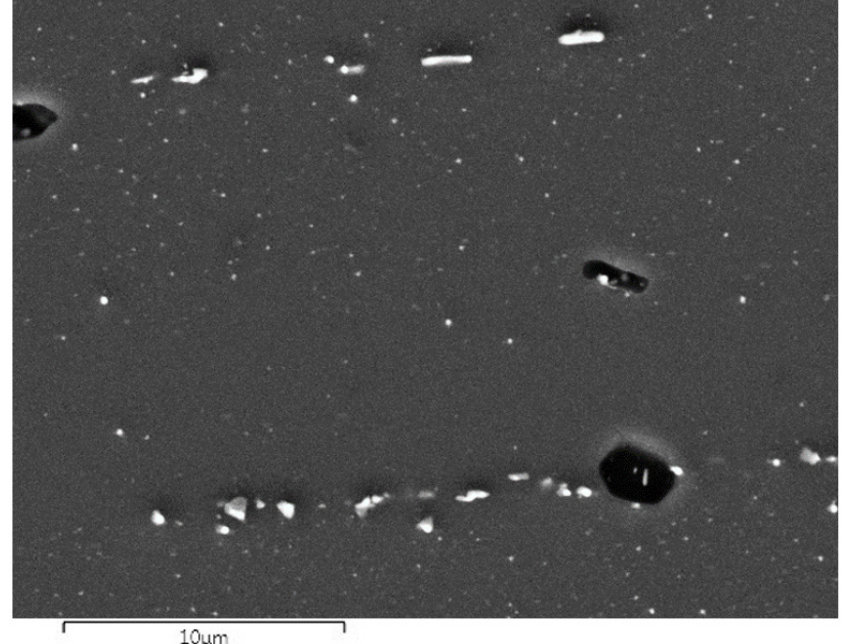
Figure 3. SEM micrograph taken in BSE Mode at higher magnification than Figure 2, showing the microstructure of 6061-T6, showing the Fe-rich constituent sizes and their distribution. Moreover, the boundary between DXZ and TMAZ is visible at approximately 300 μ m to the left from the lower tip of the tool (Figure 4). To the right of this boundary, i.e., in DXZ, the spacing of particles seems to be random. In contrast, the particles are in bands as shown in Figure 2 to the left of the boundary.